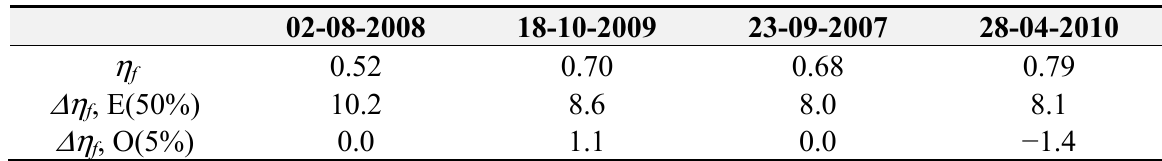
Table 4. The same as Table 3, except that these results correspond to the fine volume ). mode fraction ( η f